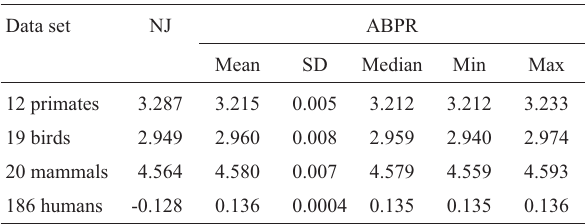
Table 1 - Total length of the trees produced by the ABPR and NJ algo- rithms. Data set